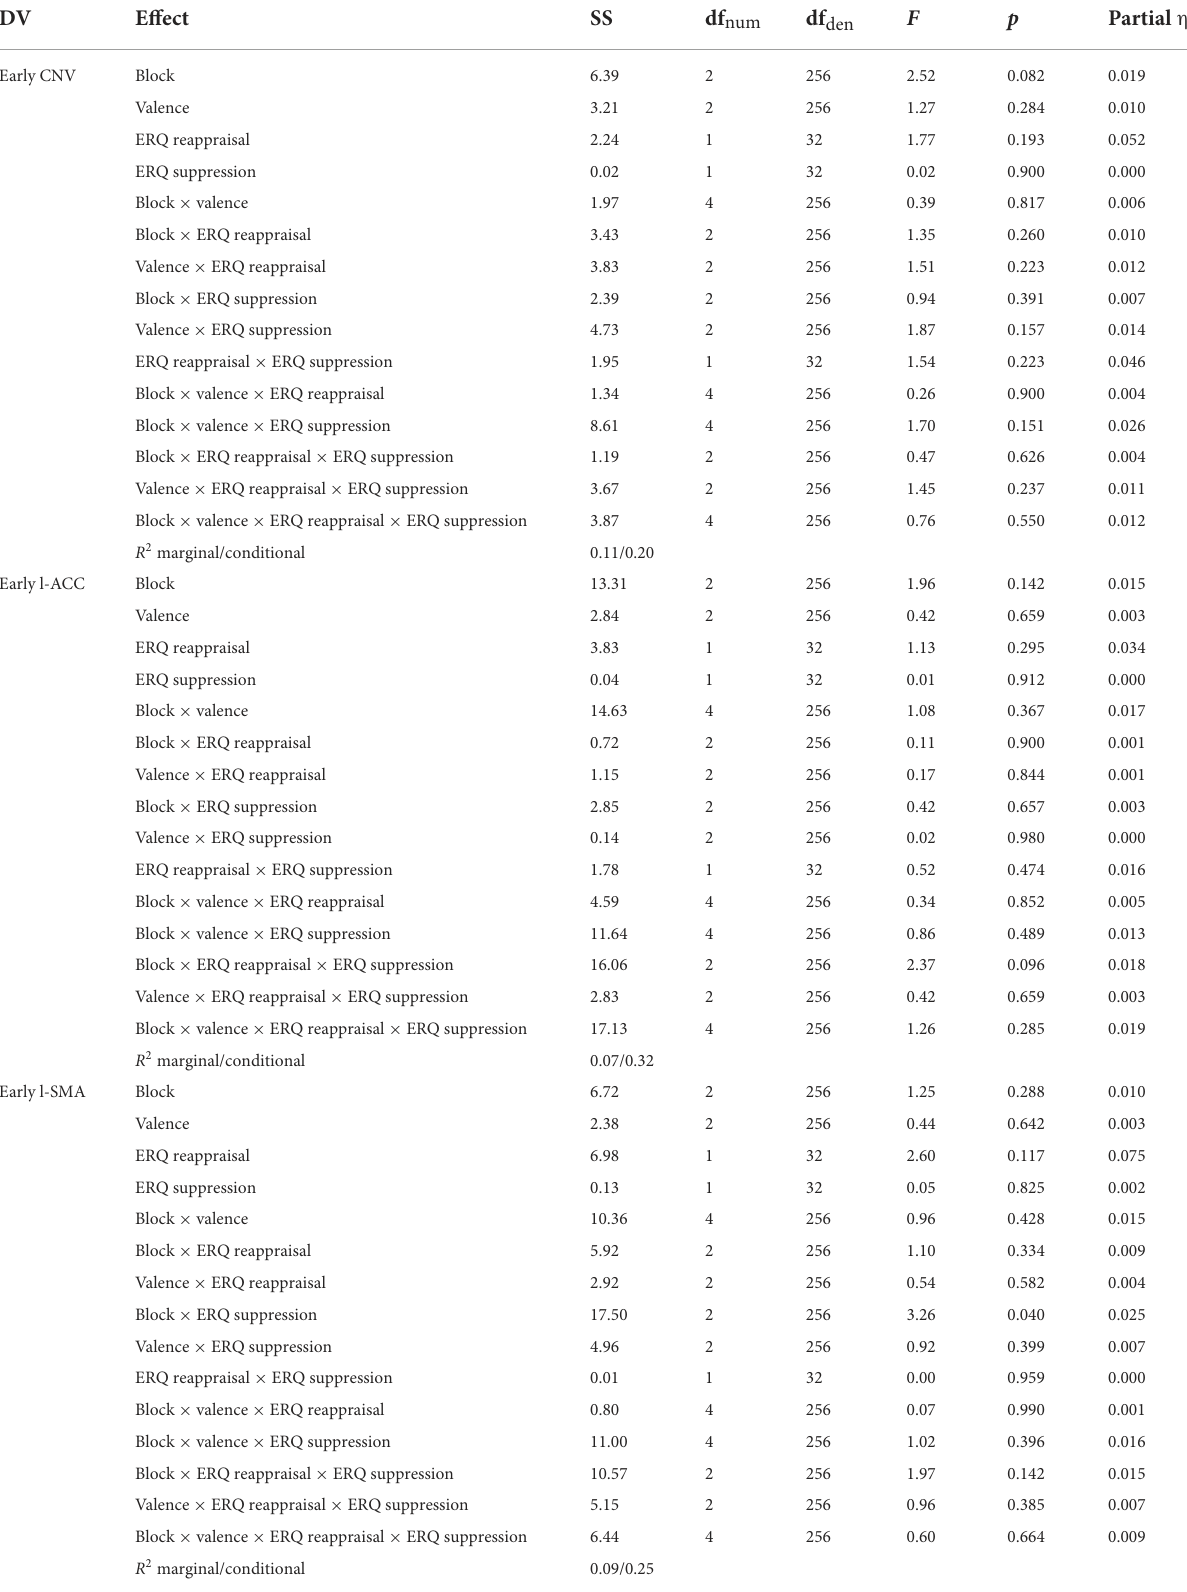
TABLE 2 ANOVA of models in the prediction implementation